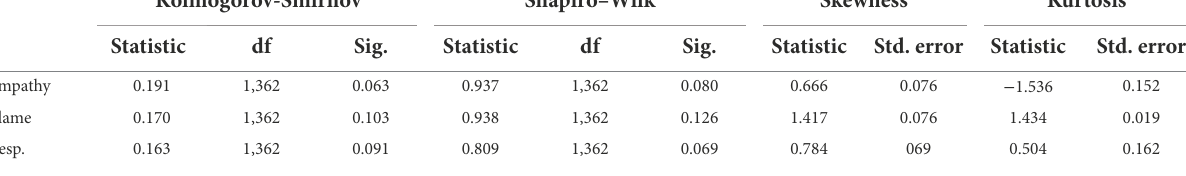
TABLE 3 Normality test.